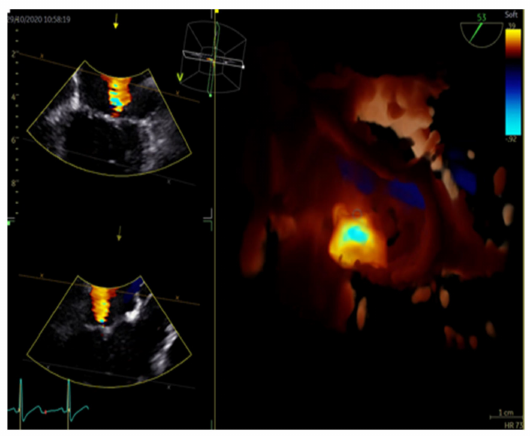
Figure 5. Three-dimensional image of the mitral valve along with color Doppler to visualize mitral regurgitation